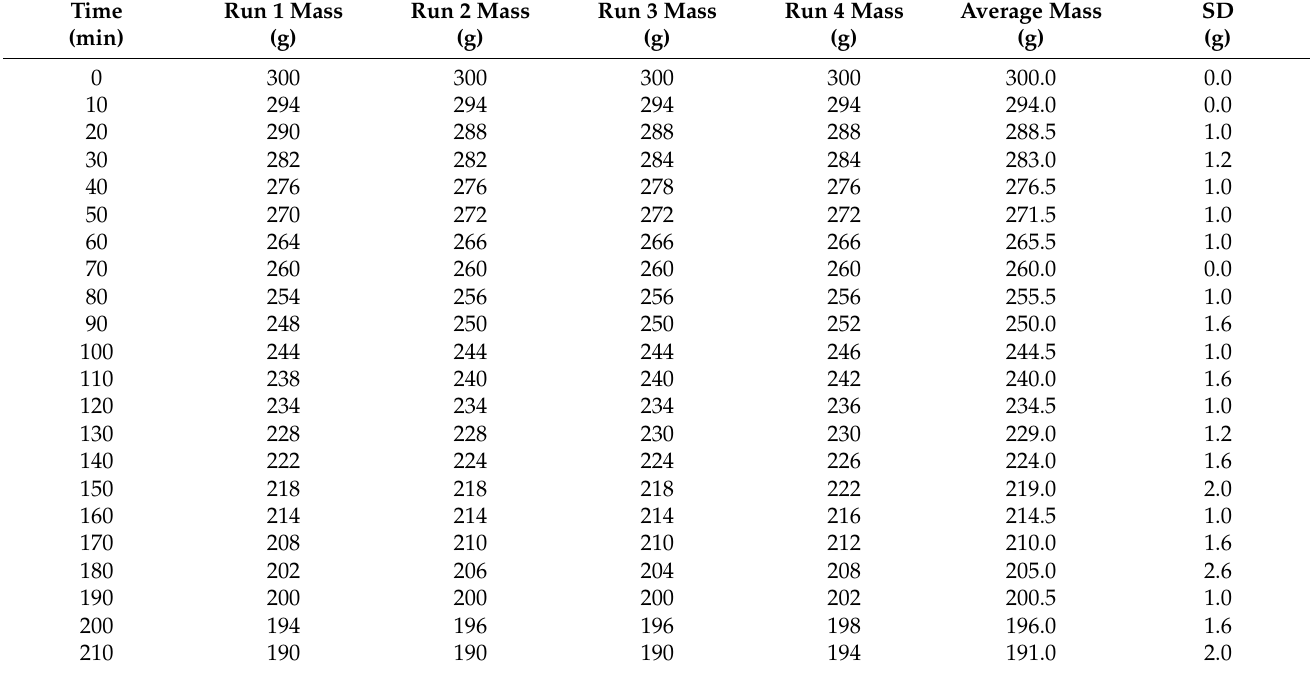
Table A1. Configuration A mass